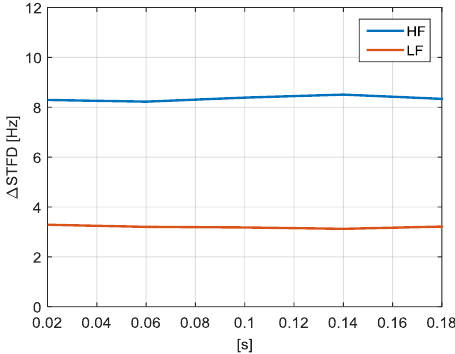
Figure 32. Case study 2: Δ STFD at low-frequency (0 ÷ 2 kHz, red line) and at high-frequency (2 ÷ 150 kHz, blue line) obtained through STFT. Energies 2017 , 10 , 1633